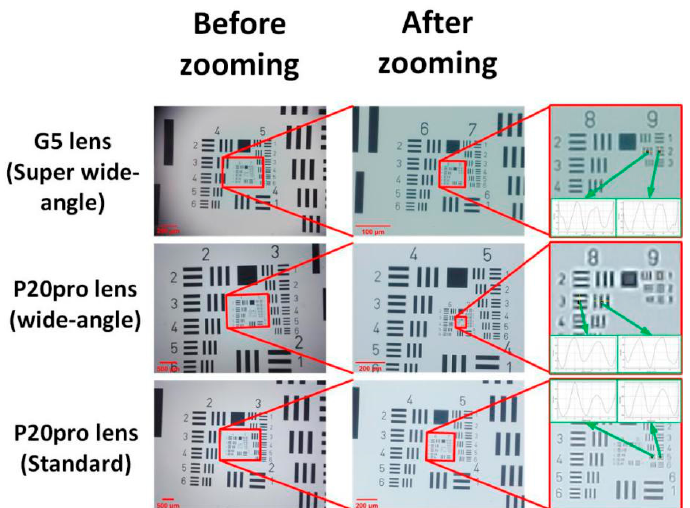
Figure 6. Evaluation of imaging performance of the built microscope. LG G5 super wide-angle lens, P20pro wide-angle lens and P20pro standard lens are taken as targets to take photos of resolution chart. When the zooming function of the cell phones is not applied, the diagonal values of the field of view (FOV) at the three magnification ratios are 2.7 mm, 6.0 mm, 9.0 mm, which correspond to the magnification ratios of 3×, 1.2× and 0.8×, respectively. The FOV is reduced when using the digital zoom of the cell phones, but the microscope can distinguish the features of 575 lp/mm, 322 lp/mm and 203 lp/mm, respectively.